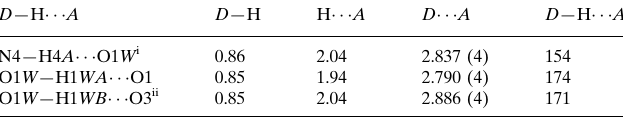
Hydrogen-bond geometry (A˚ , (cid:2)